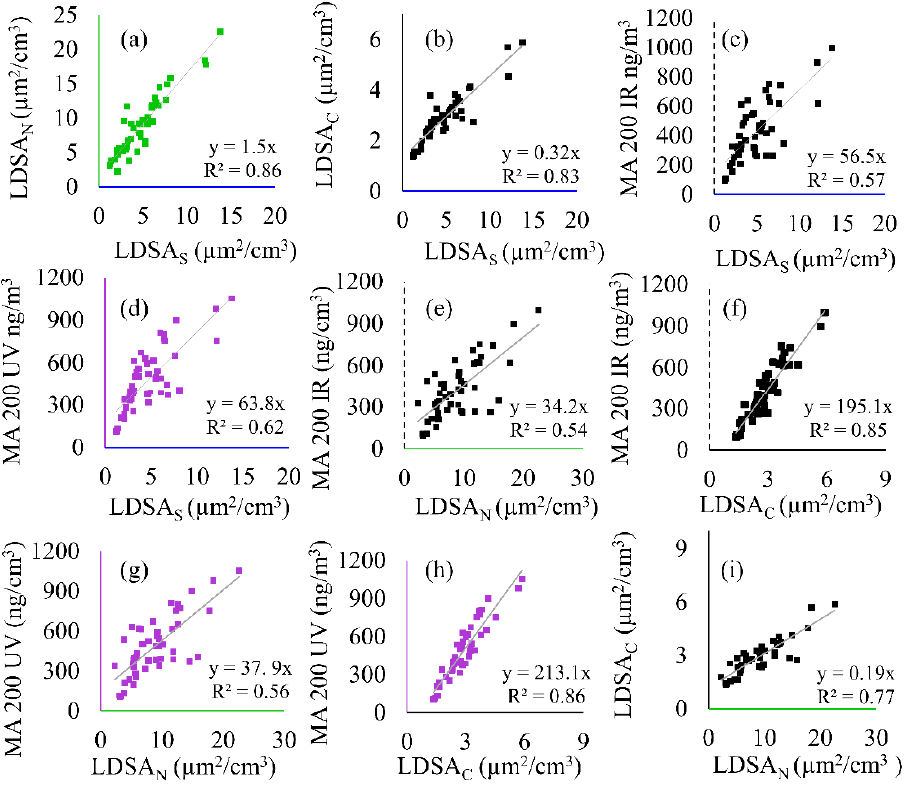
Figure 6. Correlation plots showing the linear regressions and correlation of determination (R 2 ) between all instruments including the SMPS (LDSA S ), MA200 (BC and BrC), and Naneos (LDSA N and LDSA C ) for the semi-volatile sample period. The following correlations are shown: ( a ) LDSA N to LDSA S , ( b ) LDSA C to LDSA S , ( c ) MA 200 IR to LDSA S , ( d ) MA 200 UV to LDSA S , ( e ) MA 200 IR to LDSA N , ( f ) MA 200 IR to LDSA C , ( g ) MA 200 UV to LDSA N , ( h ) MA 200 UV to LDSA C , and ( i ) LDSA C to LDSA N .